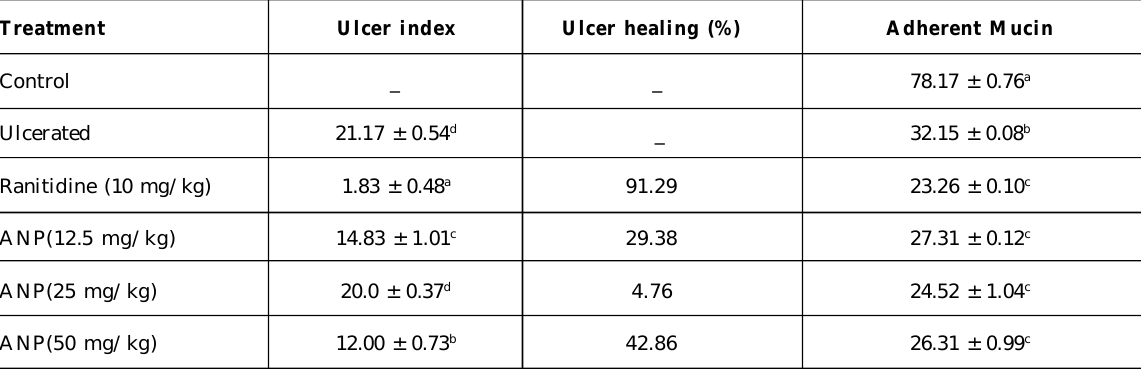
Note: Data are mean of 6 replicates ± SEM; values with different superscript are significantly different ( p < 0.05); ANP: Acacia nilotica